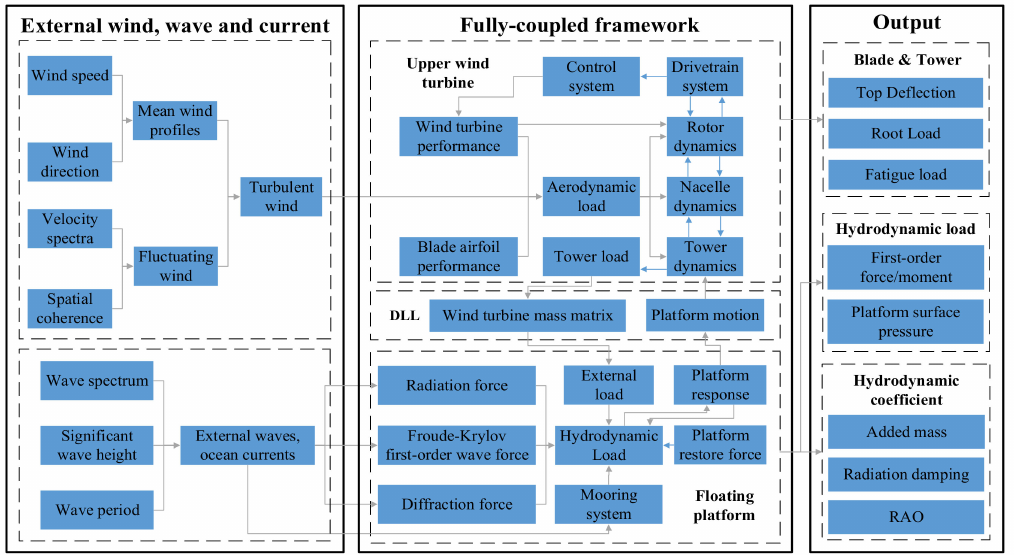
Figure 5. Calculation flow chart considering the fully coupled effect of the